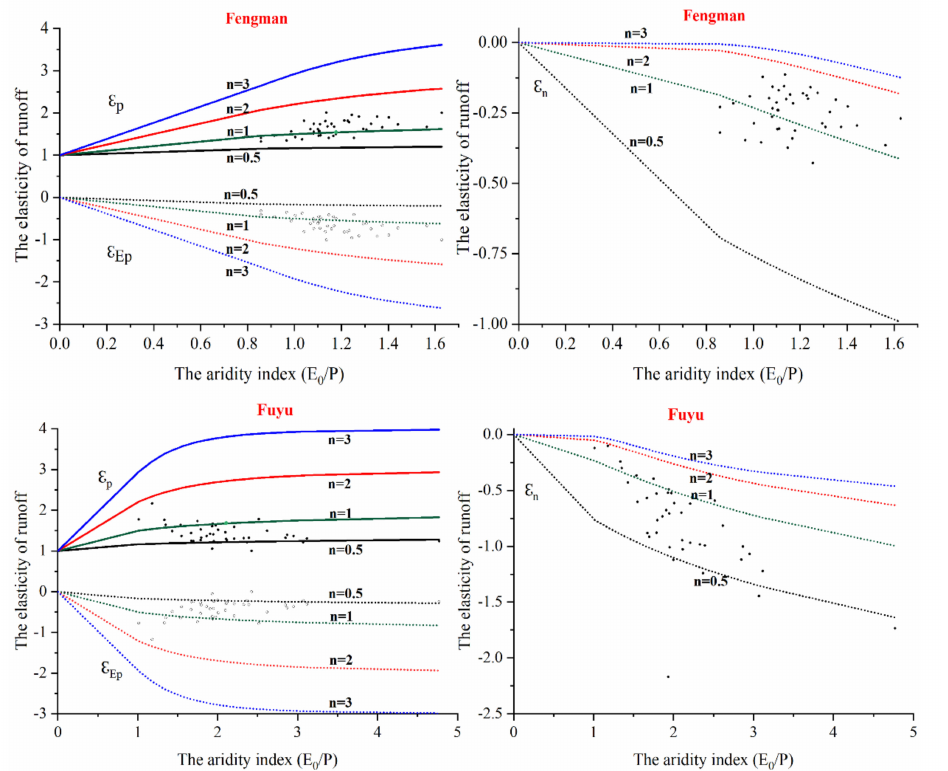
Figure 7. Relationship between the elasticity of runo ff variation with climate condition and catchment landscape parameter ( n ) in di ff erent aridity index, E 0 / P , values at the Fengman and Fuyu stations.